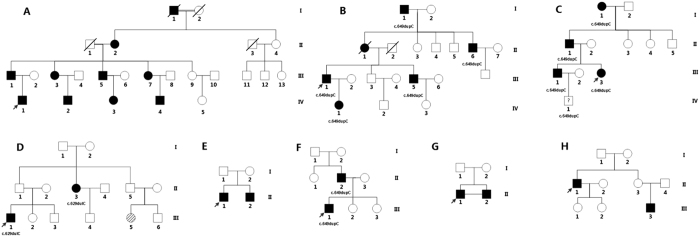
Pedigrees of PKD families and PRRT2 mutations.Males were represented by squares, and females by circles. Filled-in symbols indicated PKD symptomatic, empty circles indicated unaffected individuals. Symbols with a slash through them indicate deceased individuals. Probands are denoted by an arrow.